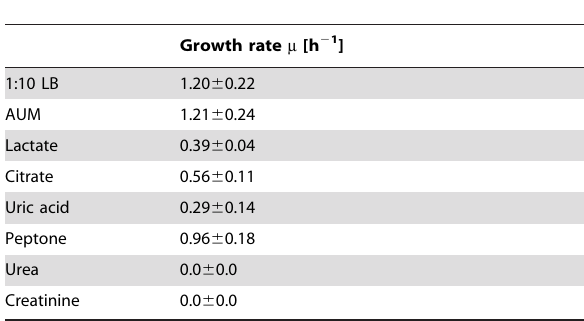
Table 3. Growth of P. aeruginosa in liquid cultures at 37 u C and 200 rpm under aerobic conditions in 10-fold diluted LB, AUM and in AUM prepared with only one single C-source